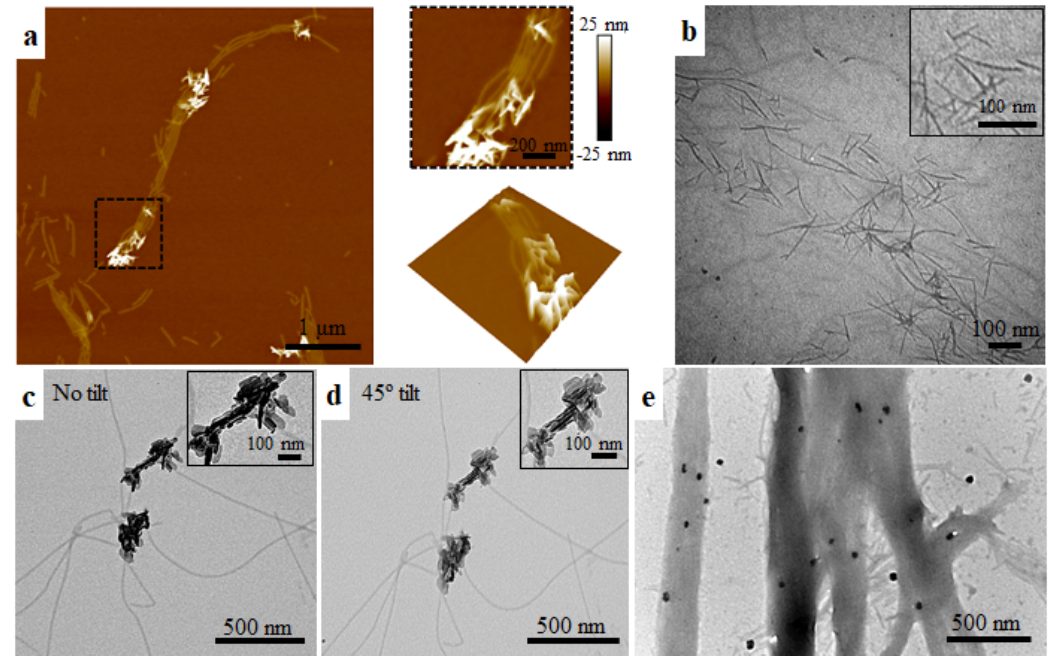
Figure 3. Co-assembly and mineralization of NA and amelotin at pH 5. ( a ) AFM and ( b ) TEM images of needle-like mineral growth along NA protein nanoribbons 20-min post co-incubation with amelotin. ( c ) Calcium phosphate mineral deposition organized along NA protein nanoribbons. ( d ) Figure 2c rotated 45° showing that the minerals are oriented along NA nanoribbons. ( e ) TEM of immunolabeled amelotin deposited along NA protein nanoribbons.